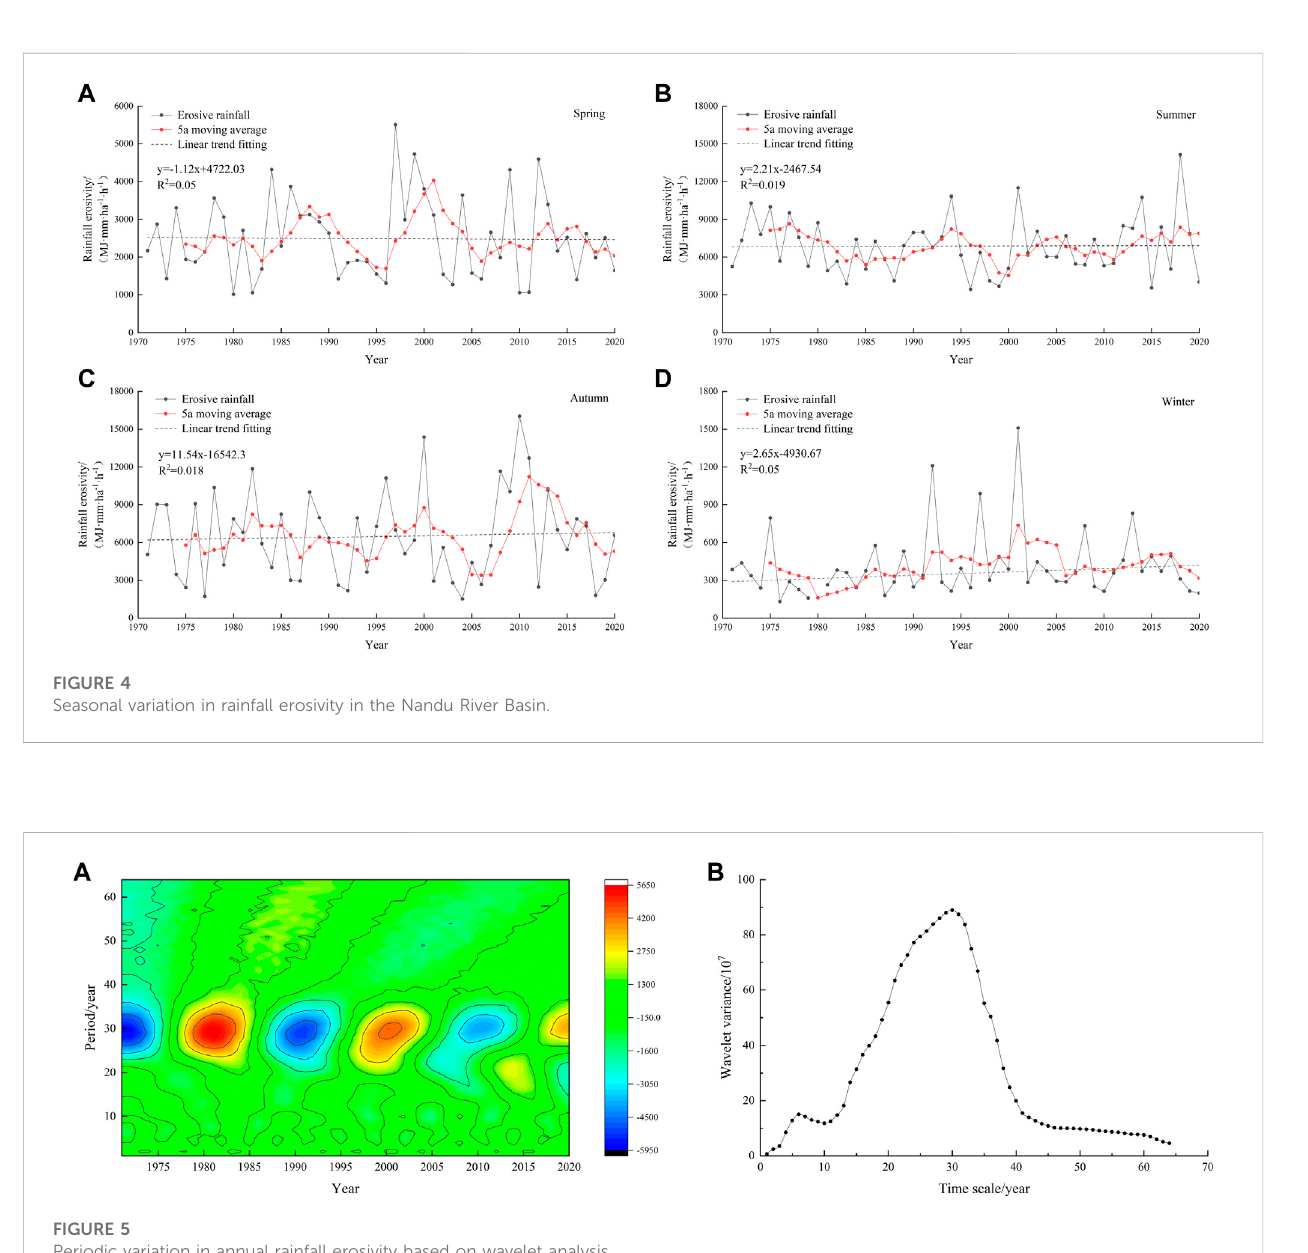
Periodic variation in annual rainfall erosivity based on wavelet